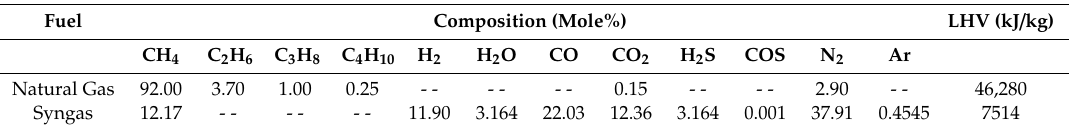
Table 3. Syngas (from olive pits) and NG